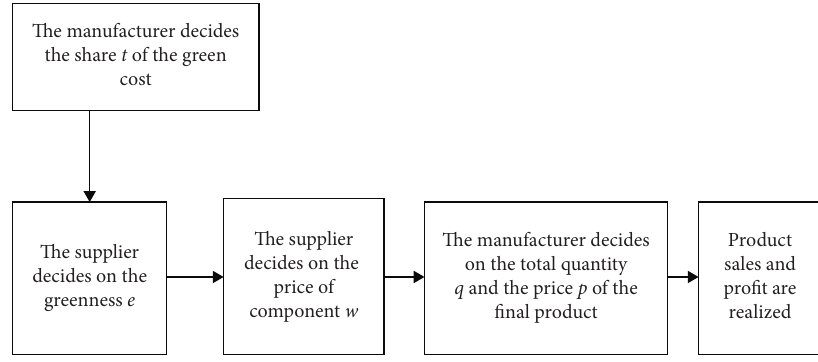
Figure 2: Decision sequence diagram of green supply chain under cooperative